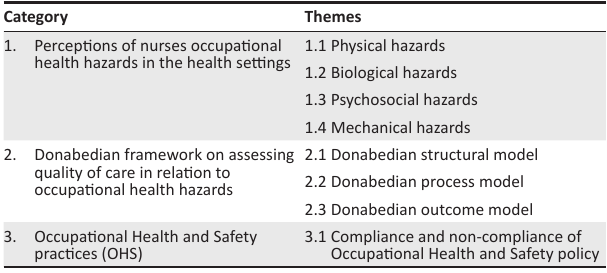
TABLE 2: Nurses’ perceptions on occupational hazards and safety practices in the